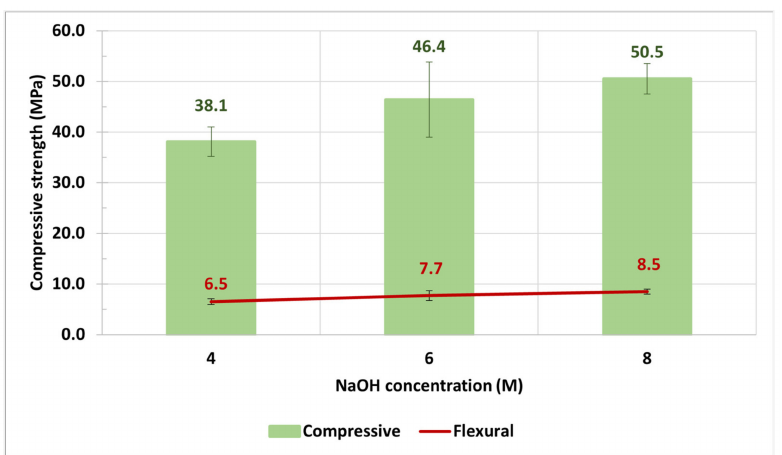
Figure 5. Effect of NaOH concentration on the W20GP sample at 28-day curing time (heat curing temperature of 60 ◦ C) with SS/SH = 1.00.